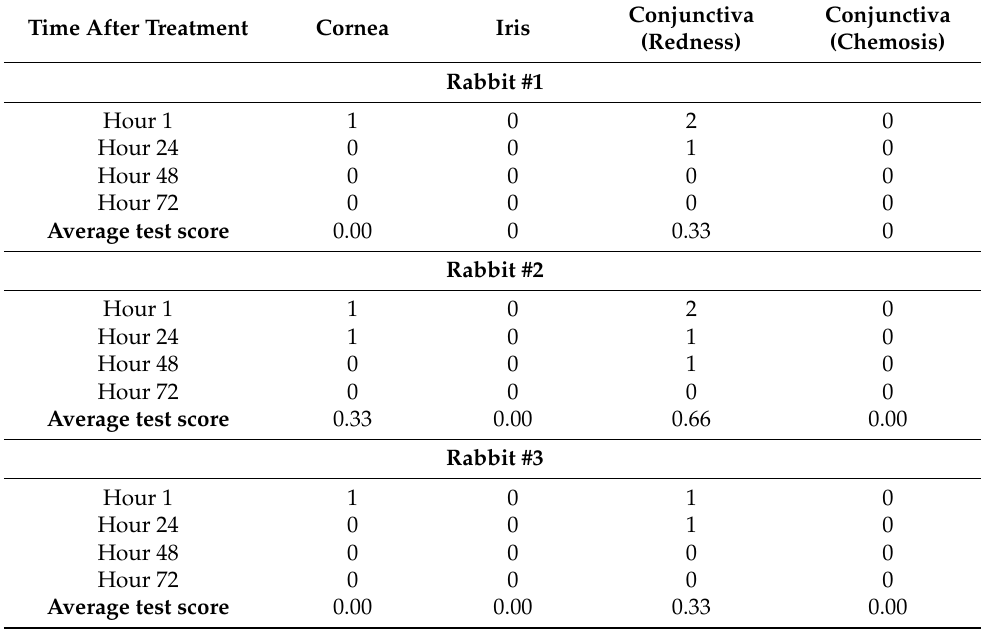
Table 8. Classification of ocular lesions in New Zealand rabbits after AgNPs treatment. Time After Treatment Cornea